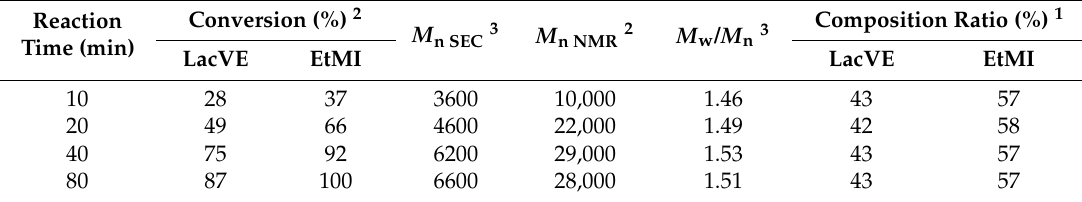
Table 2. RAFT copolymerization of LacVE and EtMI 1 .